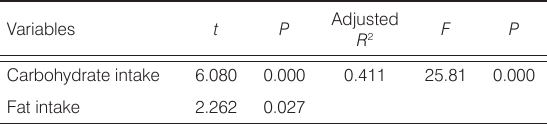
Table 3. Multivariate analysis between the intake of carbohydrates, proteins, and fats and random blood sugar